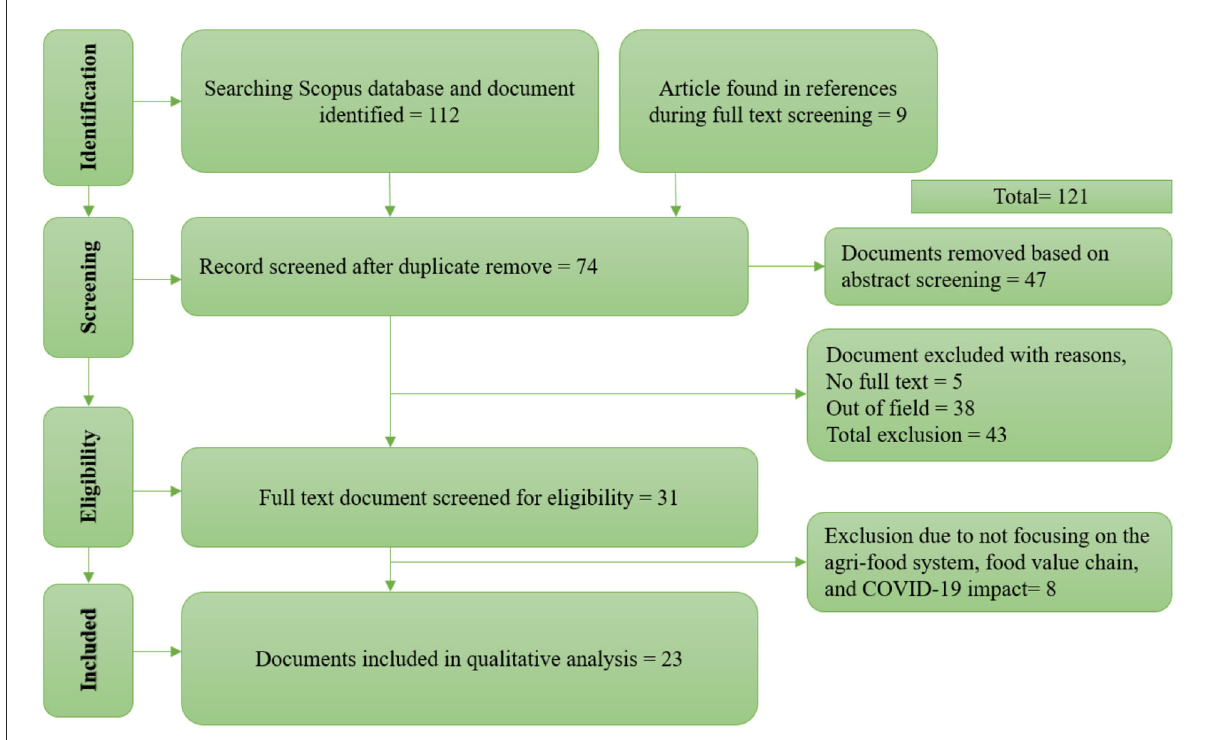
FIGURE1 Document selection by PRISMA. A qualitative analysis was done on the selected 23 documents following the research questions. This study extracted the key information from the selected documents according to the study objective for showing a comprehensive understanding on the agri-food system resilience amid